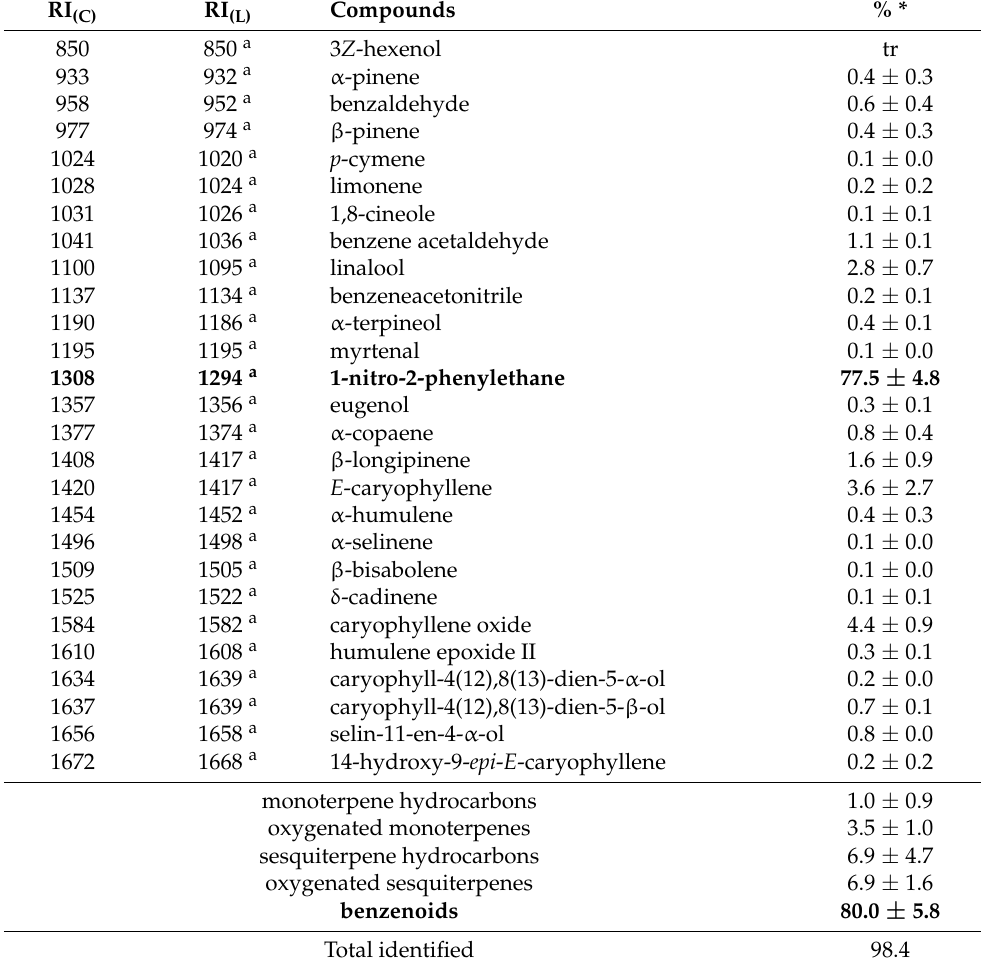
Table 1. Chemical composition of Aniba canelilla essential oil.